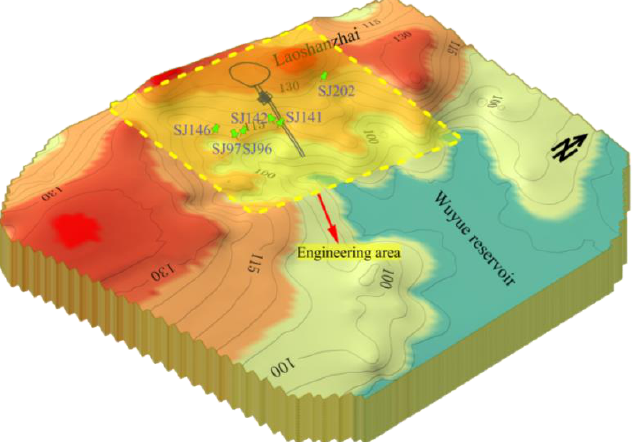
Figure 2. A three - dimensional digital elevation model of the engineering area. Figure 2. A three-dimensional digital elevation model of the engineering